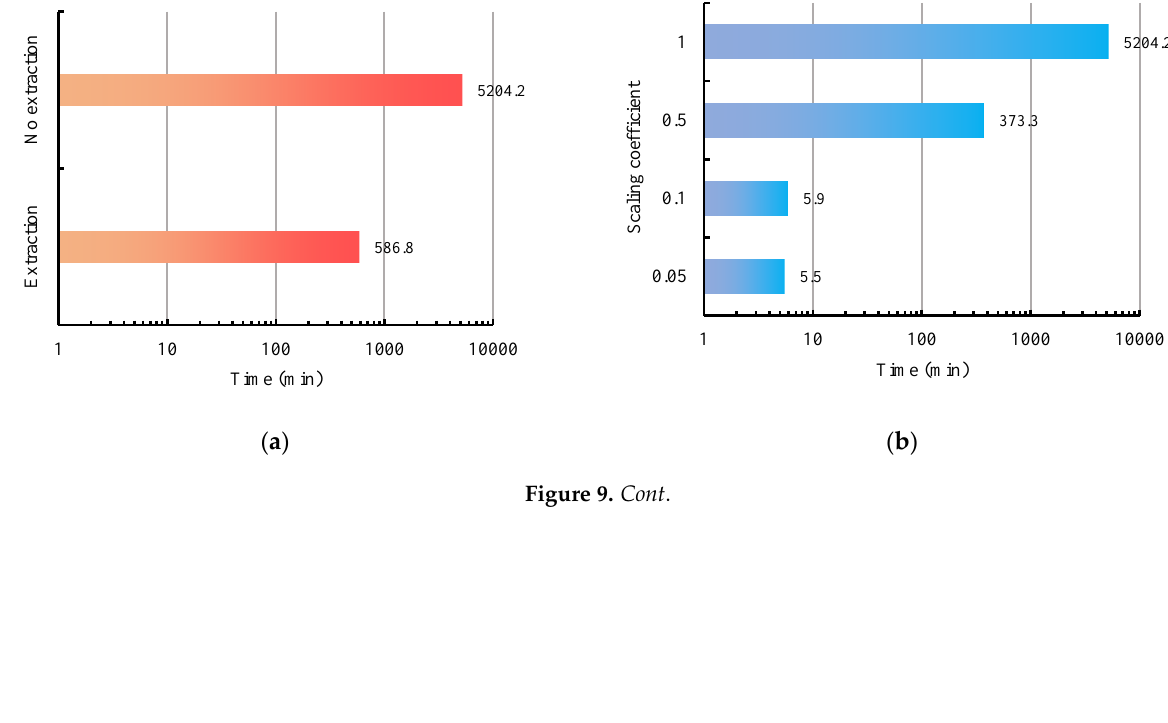
Table 3. Parameters of the six GF-3 ScanSAR images.